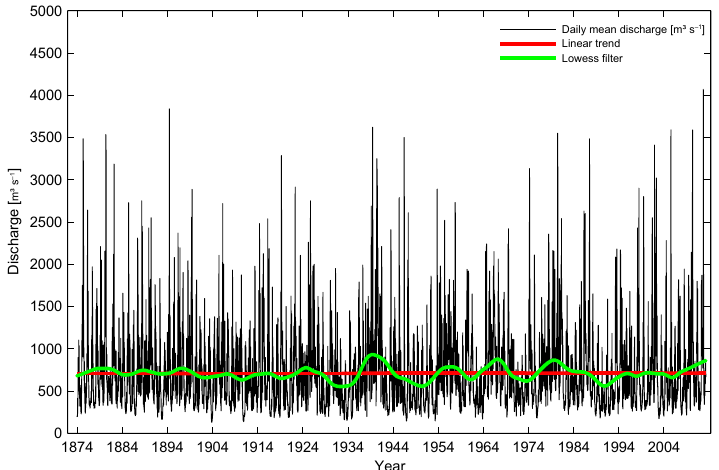
Figure 2. Daily mean discharge of gauge Neu Darchau from 1875 to 2013 with linear and non-linear trend (LOWESS, span = 10 years).